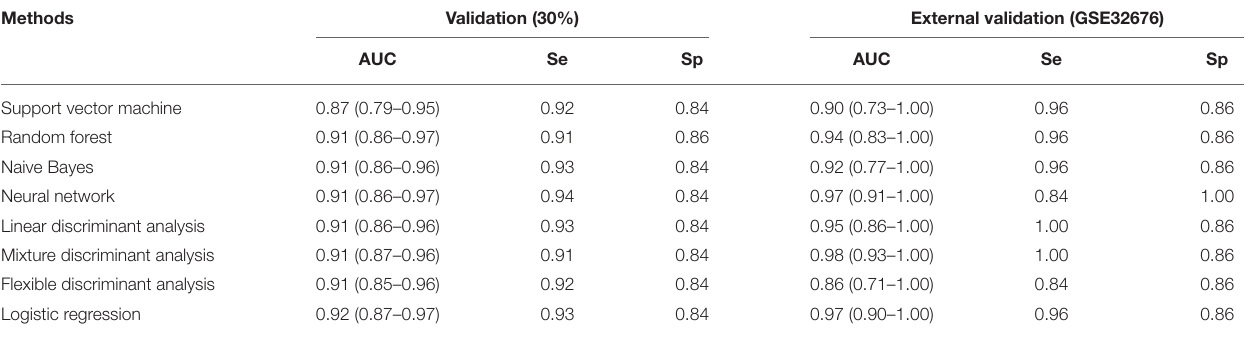
TABLE 3 | Diagnostic performance of eight machine learning methods for pancreatic